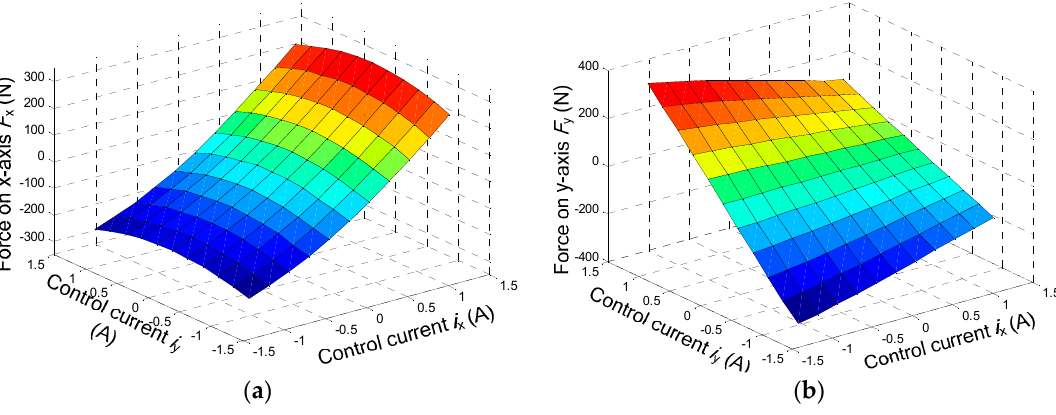
Figure 4. 3 ‐ D finite element analysis results of three ‐ pole radial ‐ axial hybrid magnetic bearings Figure 4. 3-D finite element analysis results of three-pole radial-axial hybrid magnetic bearings (HMB). (HMB). ( a ) Force ‐ current characteristics on x ‐ axis; ( b ) Force ‐ current characteristics on y ‐ axis. ( a ) Force-current characteristics on x -axis; ( b ) Force-current characteristics on y